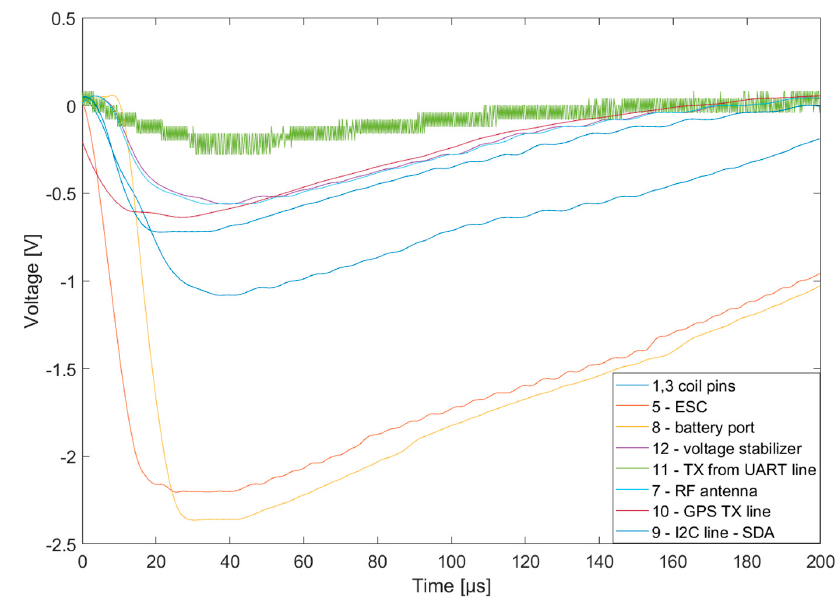
Figure 7. Overvoltage on all measurement circuits—input surge on supply bus (point no. 8) at negative polarity.